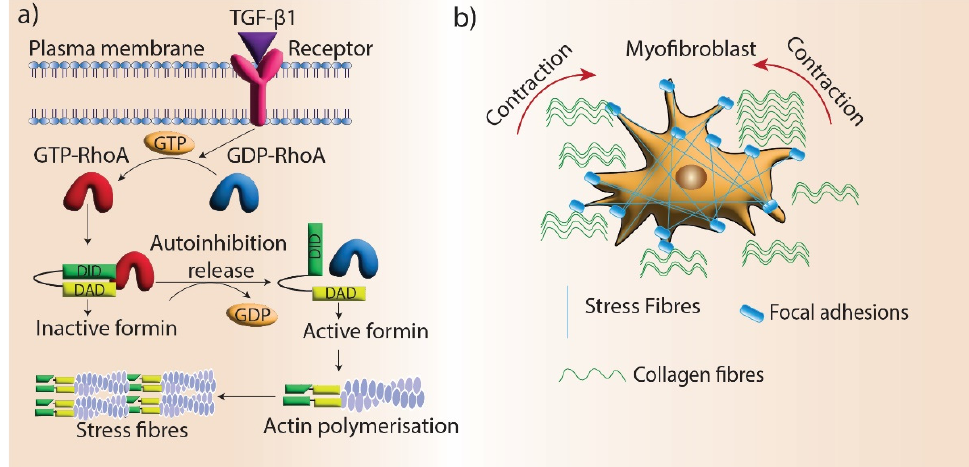
Figure 4. Formins’ role in myofibroblast contraction. ( a ) Stress fiber generation by formin-mediated actin assembly. TGF- β 1 signaling promotes stress fiber formation in myofibroblasts by mediating the activation of RhoGTPase, which blocks the autoinhibition of formins and promotes actin assembly. ( b ) Stress fibers locate in the focal adhesions of myofibroblasts and facilitate the contraction and maturation of new ECM.